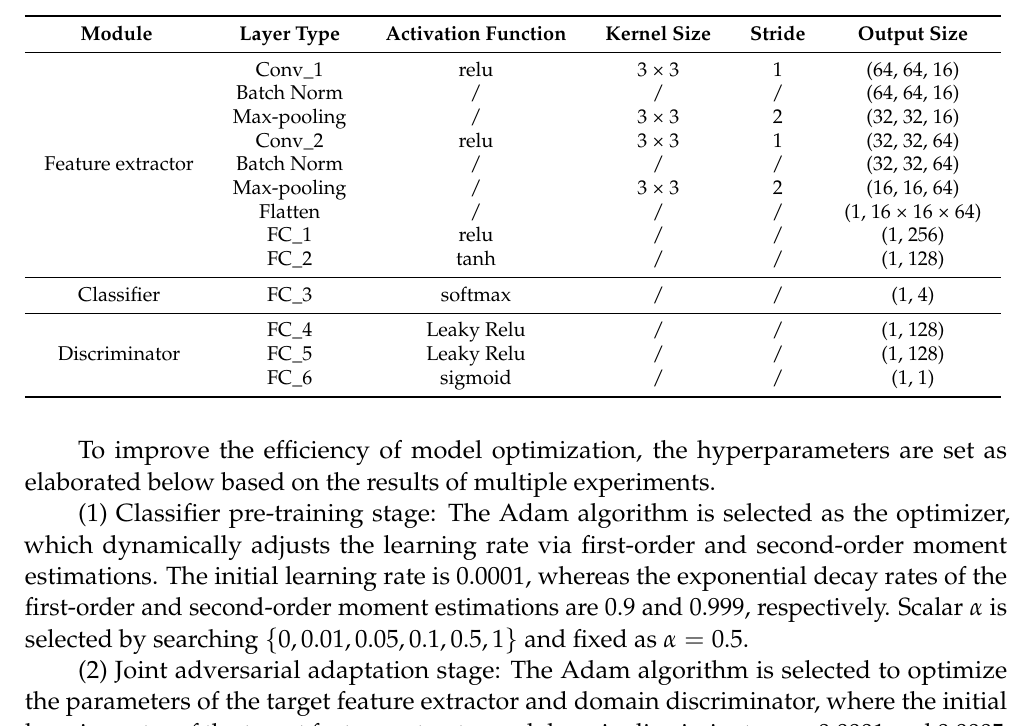
Table 3. Hyperparameters of